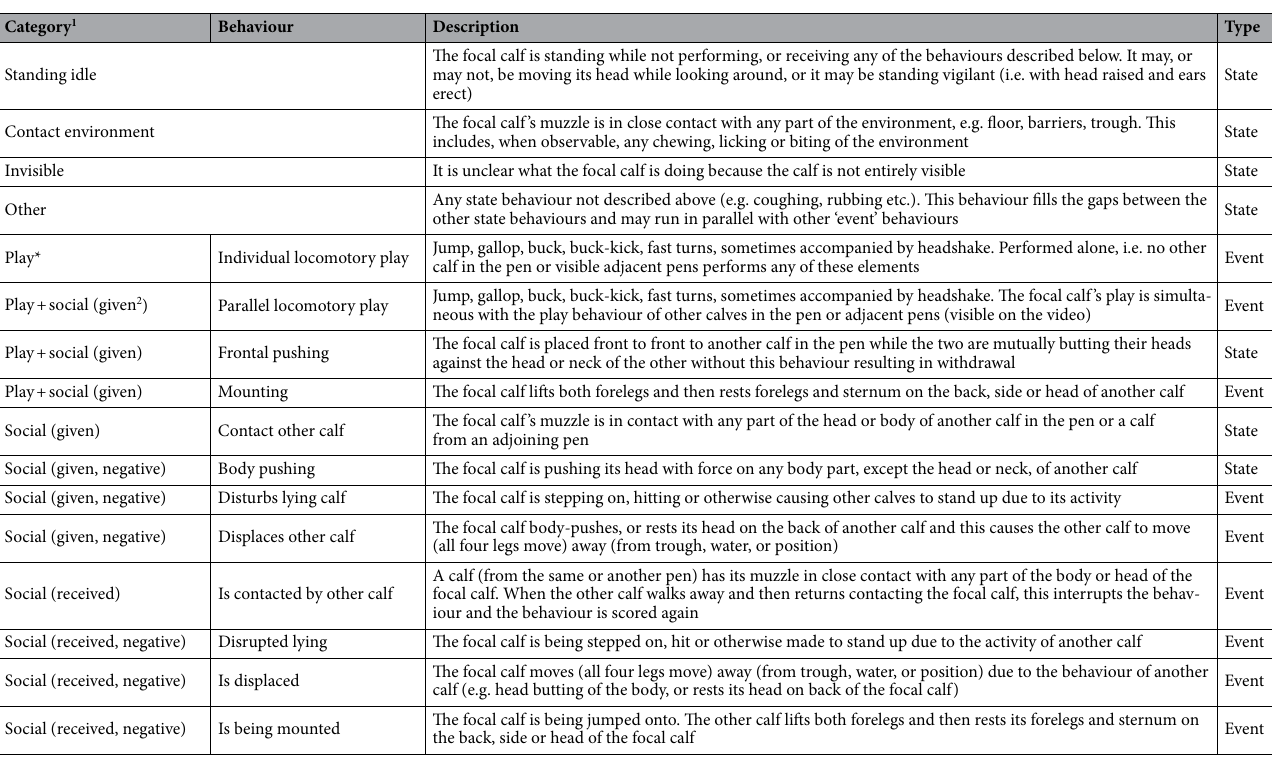
Table 1. Behaviours and definition used in this study. Categories used for analysis are provided 1 . *Jensen et al. 57 . 1 State (durations) and event (counts) social behaviours were grouped into separate categories, which means that the following (categories of) behaviours were ultimately analysed: standing idle (duration), contact environment (duration), play (count), social interactions (duration), social interaction (count), social interaction given (count), social interaction received (count), negative social interaction (count). 2 The terms given and received indicate whether the calf was the actor in the behaviour or was receiving the behaviour from another calf,